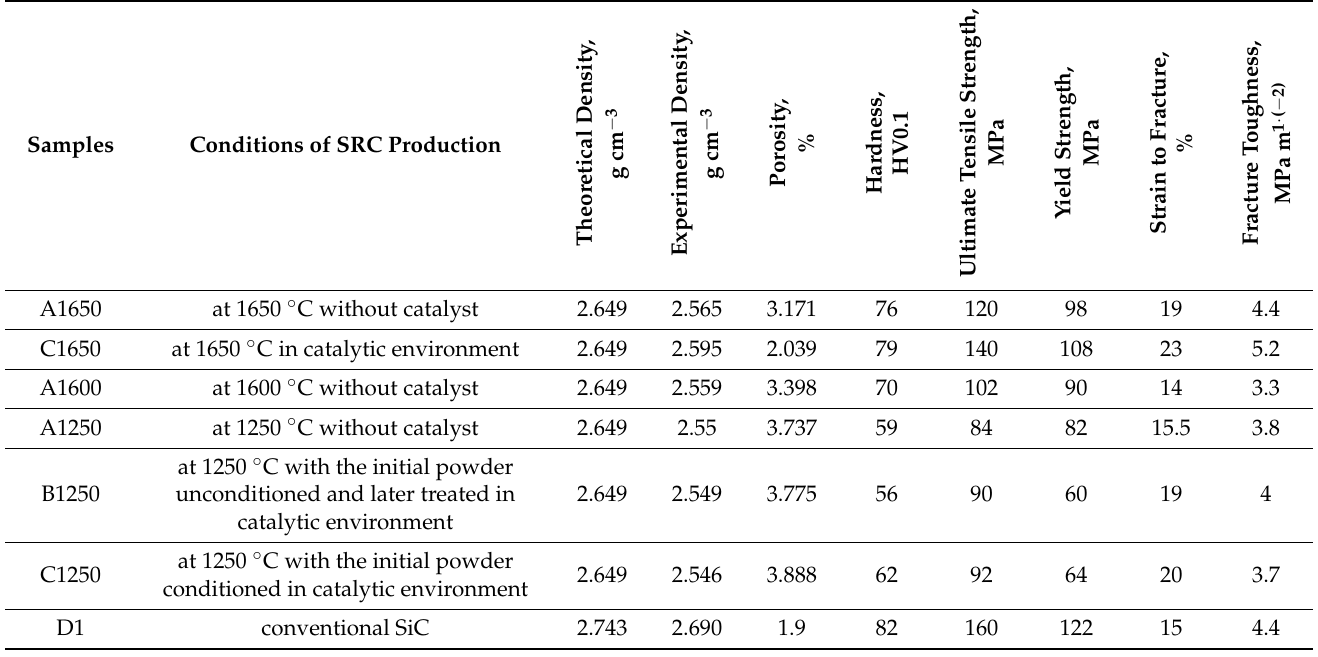
Table 15. Characteristics of Al-Mg-Si alloy-based composites. Data from [32].